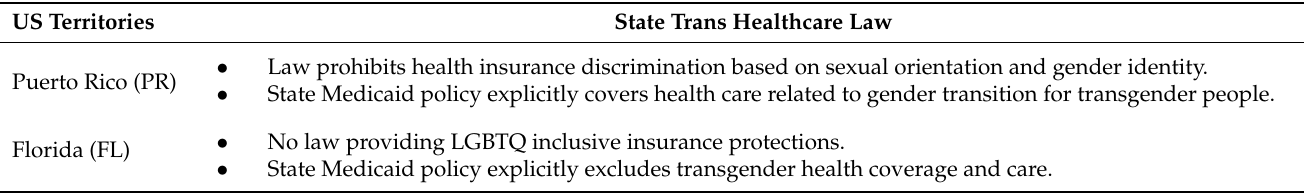
Table 2. PR and FL state trans healthcare